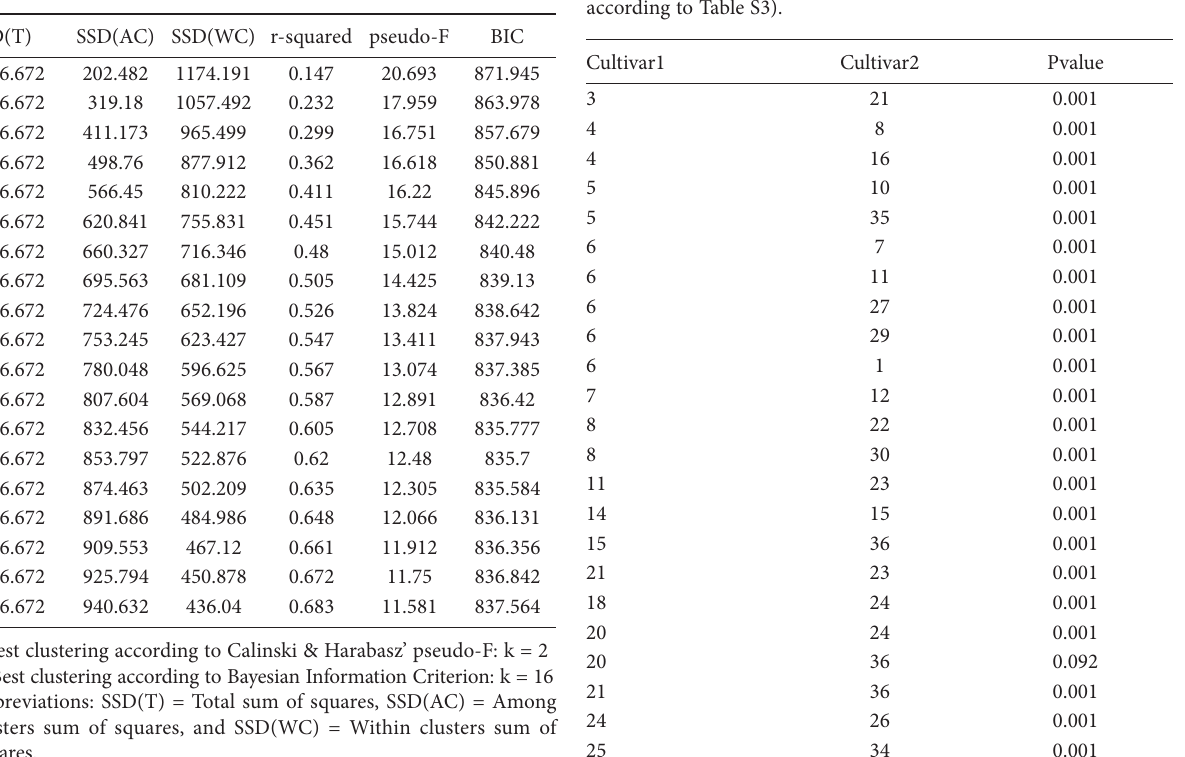
Table S4. K-Means clustering of date palm cultivars based on SSR and EST-SSR data.